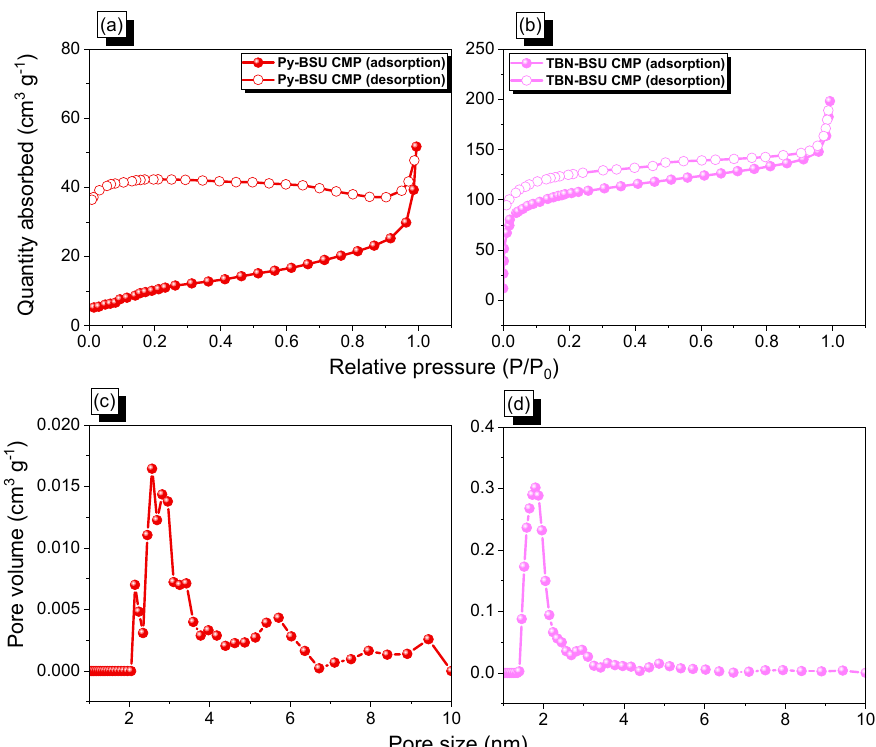
Figure 2. ( a , b ) N 2 adsorption/desorption isotherms and ( c , d ) pore size distribution pro fi les of ( a , c ) Py-BSU CMP and ( b , d ) TBN-BSU CMP. Py-BSU CMP and ( b , d ) TBN-BSU